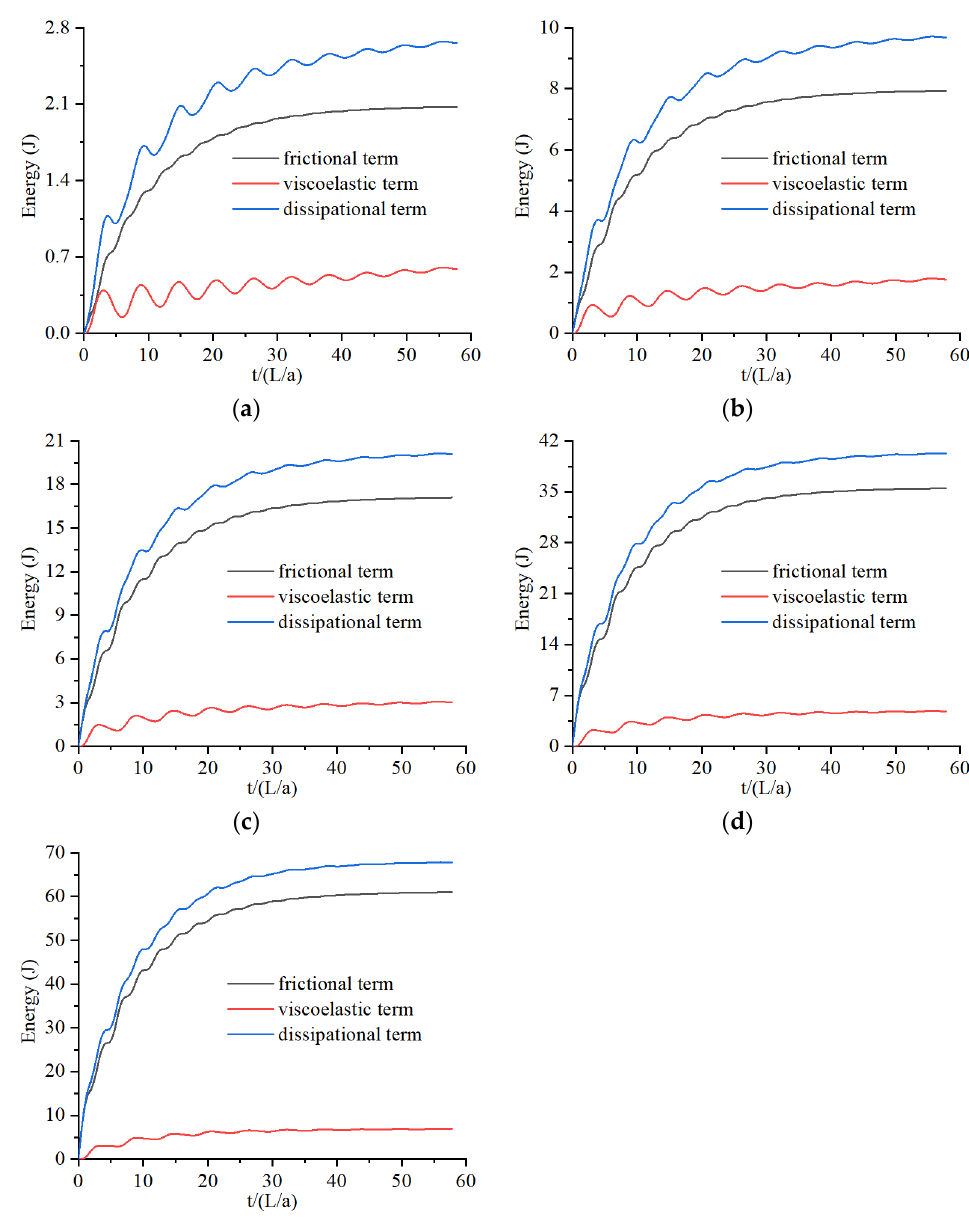
Figure 10. Energy variation of 2D model in critical region at different Re values: ( a ) Re = 13,880; ( b ) Re = 28,320; ( c ) Re = 40,950; ( d ) Re = 55,940; ( e ) Re = 69,680.